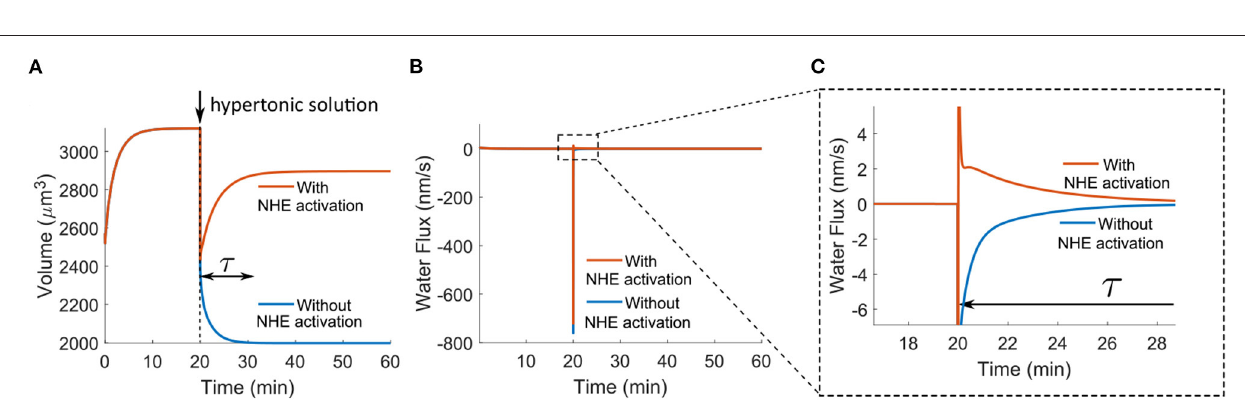
FIGURE 4 | Model predictions of the cellular response upon NHE inhibition at t 0 = 20 min. The permeability coefficient of NBC has been increased by 20 times as compared to the value used in Figures 2 , 3 . (A) Cell volume change upon NHE inhibition. (B) Predicted intracellular ion concentrations over time. (C) Ion fluxes across various channels and transporters over time. (D) Contour plot of the steady-state cell volume as a function of the permeability coefficients of NBC and NHE. (E) Changes in the intracellular pH. (F) Steady-state cell volume as a function of the permeability coefficient of NHE.